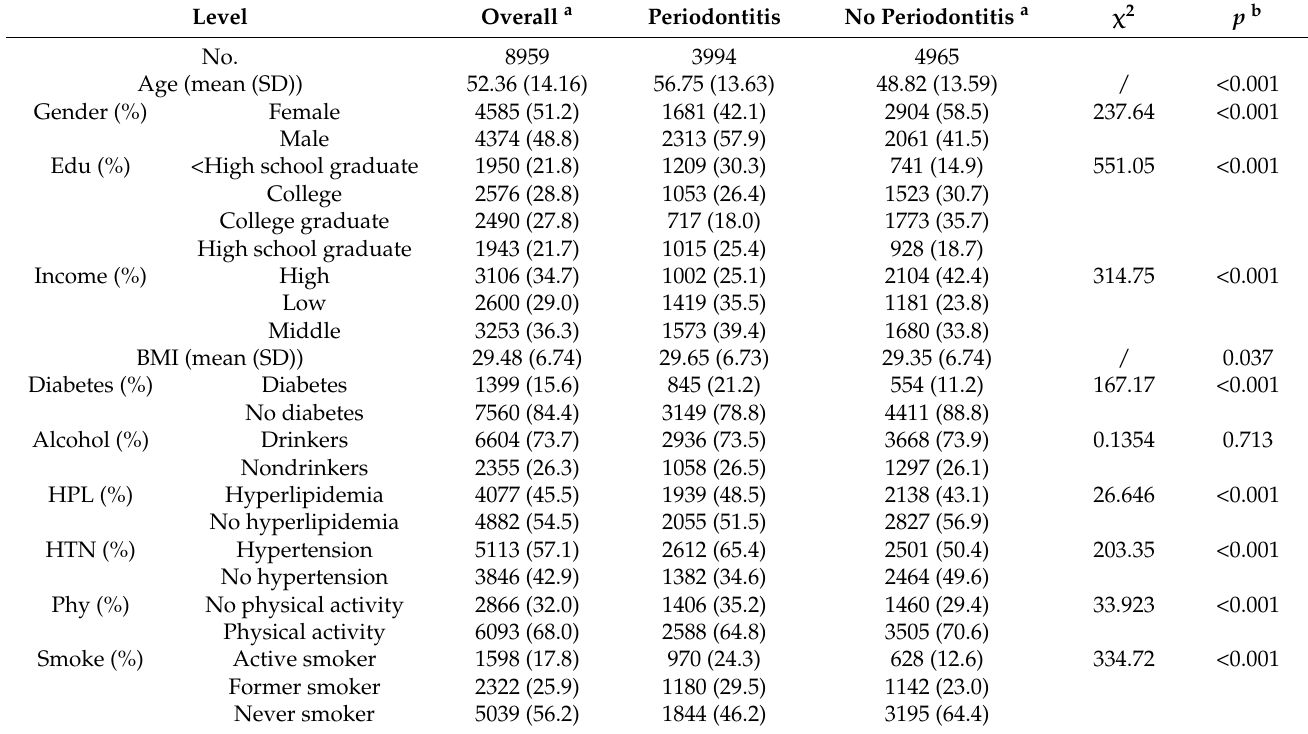
Table 1. Characteristic of